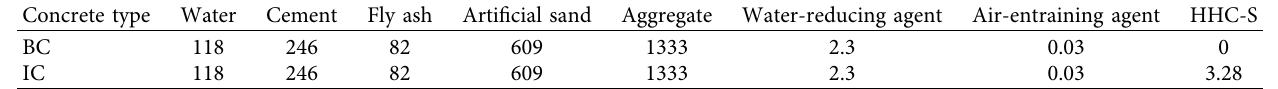
Table 1: Concrete mix ratio ( kg/m 3 ) .